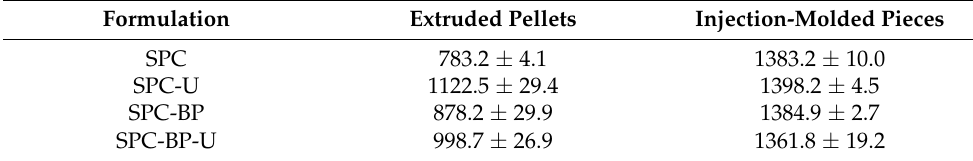
Table 2. Density (kg/m 3 ) of the extruded pellets and the resulting injection-molded pieces.